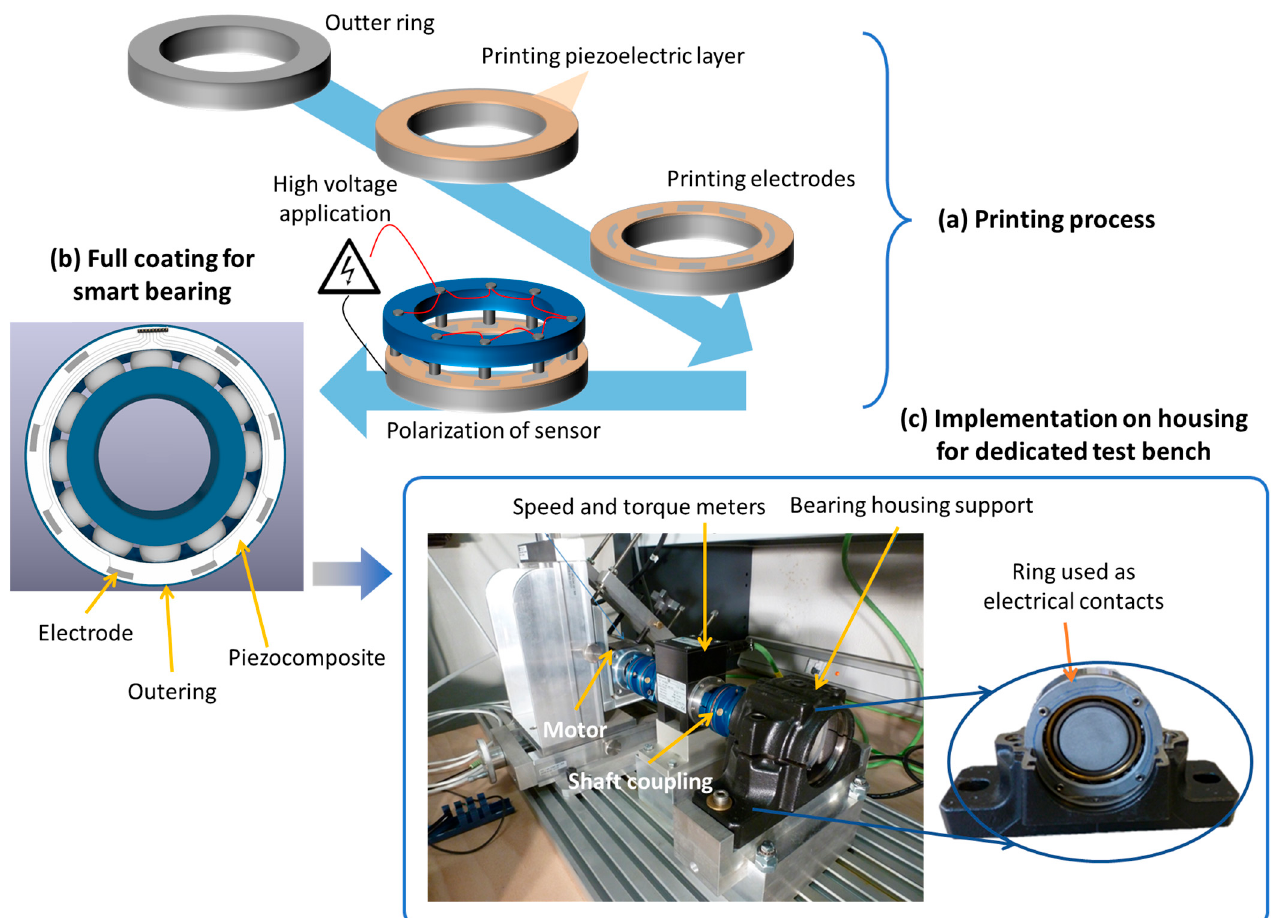
Figure 14. Future developments in smart sensor coating for condition monitoring of applied load: ( a ) printing process, ( b ) full design of smart bearings; and ( c ) implementation in housing for dedicated test bench.